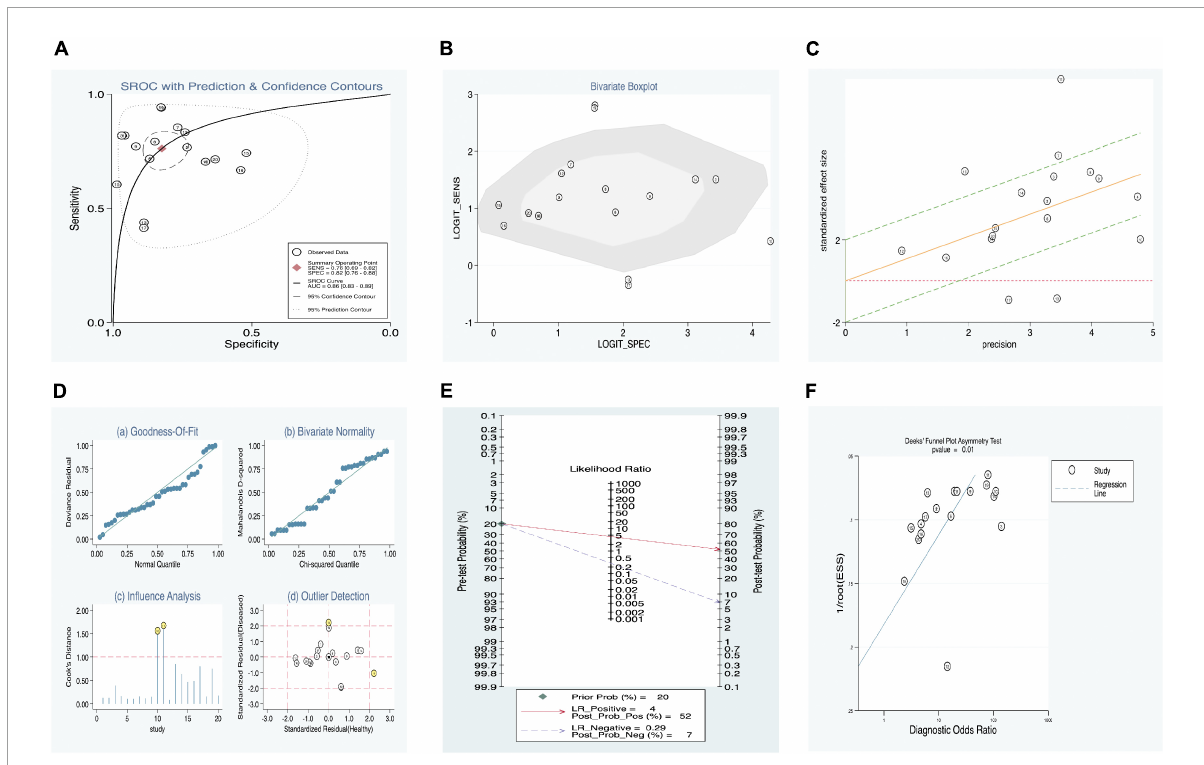
FIGURE3 Estimation of diagnostic accuracy of overall SF in KD. (A) Summary receiver operator characteristic (SROC) curve; (B) bivariate boxplot; (C) Galbraith plot; (D) Cook’s distance plot; (E) Fagan’s nomogram; (F) Deek’s funnel